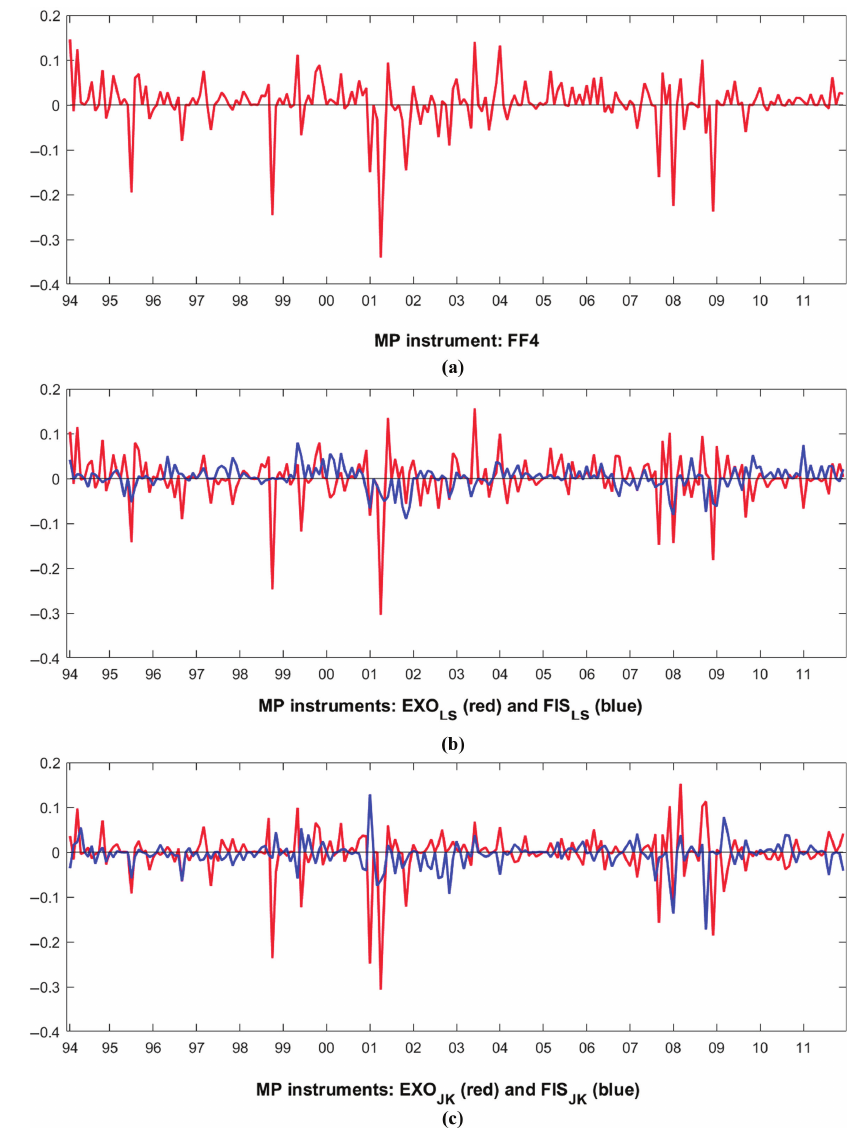
Note(s): The figures plot five MP instruments. FF4 is the high-frequency price change of the three-month ahead Fed fund futures around FOMC announcements. EXO LS and FIS LS Figure 1. ( EXO JK and FIS JK ) are its decomposition into exogenous monetary policy shock and Fed External MP information shock by Lakdawala and Schaffer (2019), respectively (Jarocinski and Karadi,